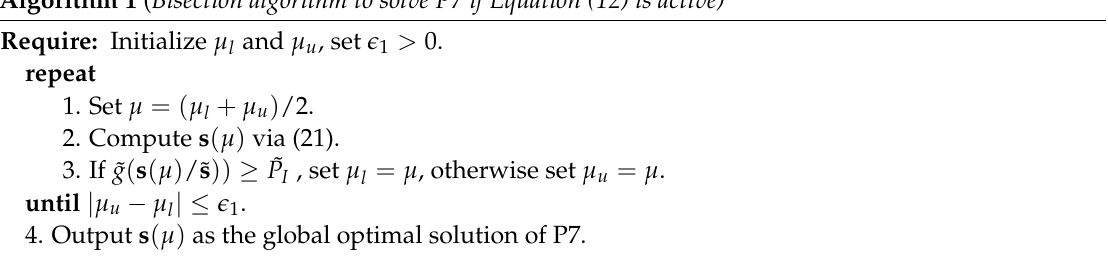
Algorithm 1 ( Bisection algorithm to solve P7 if Equation (12) is active)